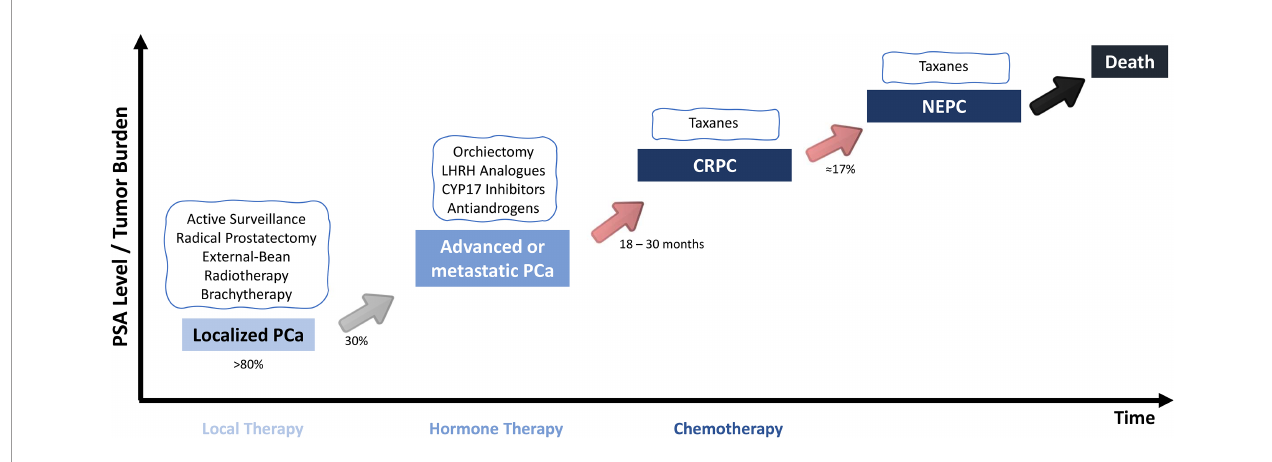
FIGURE 1 | Standard of care for the different PCa stages. For Localized PCa, RP is the interventional standard of care. On the other hand, for advanced and metastatic disease, ADT is the recommended treatment. However, nearly all patients stop responding ADT and progress to a CRPC, for which there are no effective treatment options. Moreover, about 17% of the patients with a castration-resistant form of the disease will develop neuroendocrine differentiation, which is independent of AR signaling pathway. PSA, prostate-speci fi c antigen; PCa, prostate cancer; CRPC, castration-resistant prostate cancer; NEPC, neuroendocrine prostate